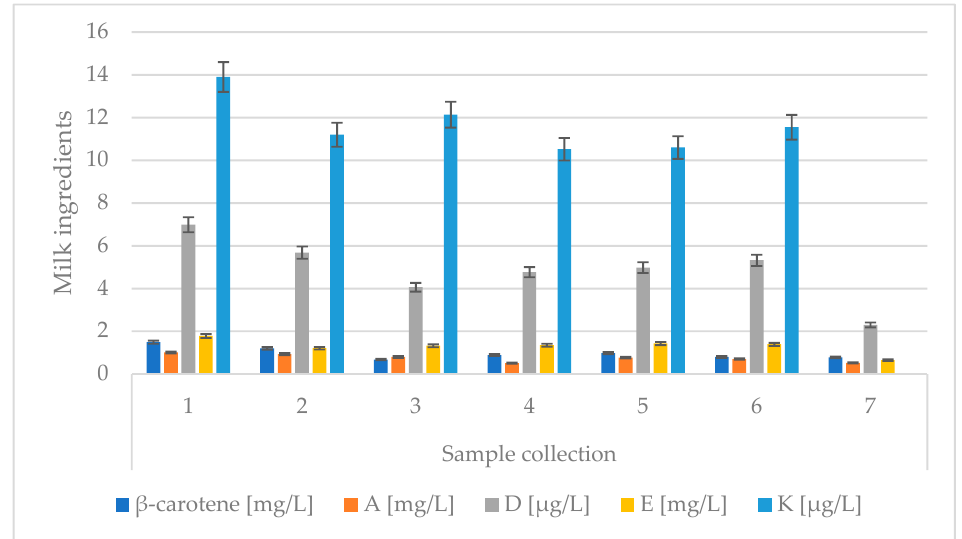
Figure 5. Changes in vitamin values in colostrum for subsequent colostrum samples. Data are presented as least squares means along with their standard errors of mean. Statistical differences between collection groups at p ≤ 0.01.